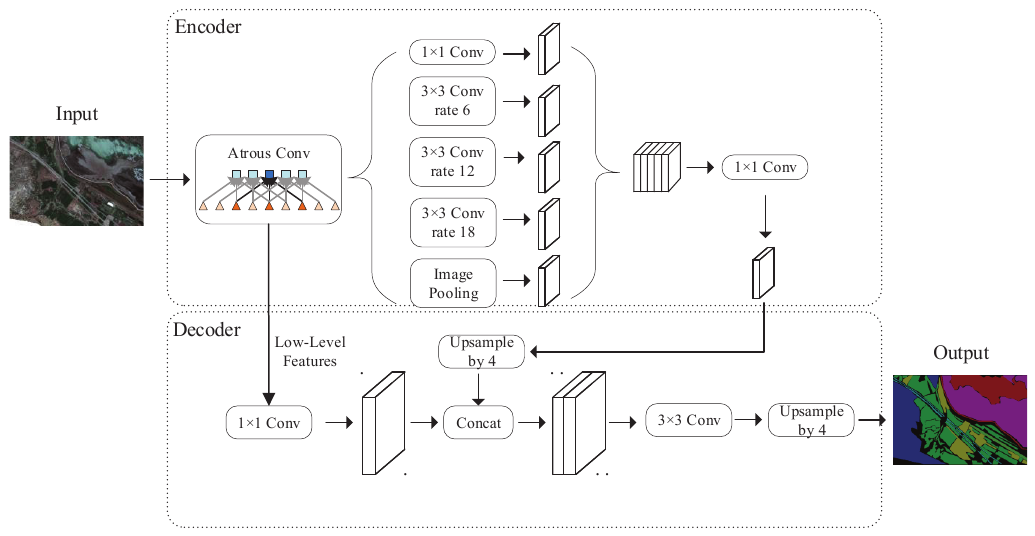
Figure 5. Structure diagram of DeepLab